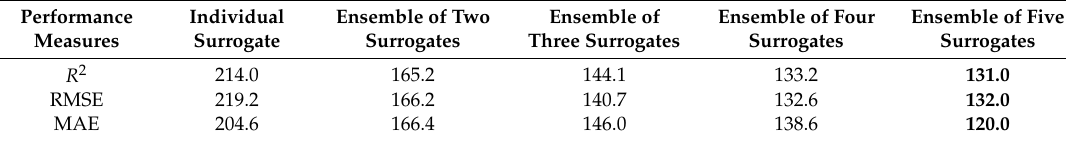
Table 6. Comparison of performance measures on ensemble models with di ff erent